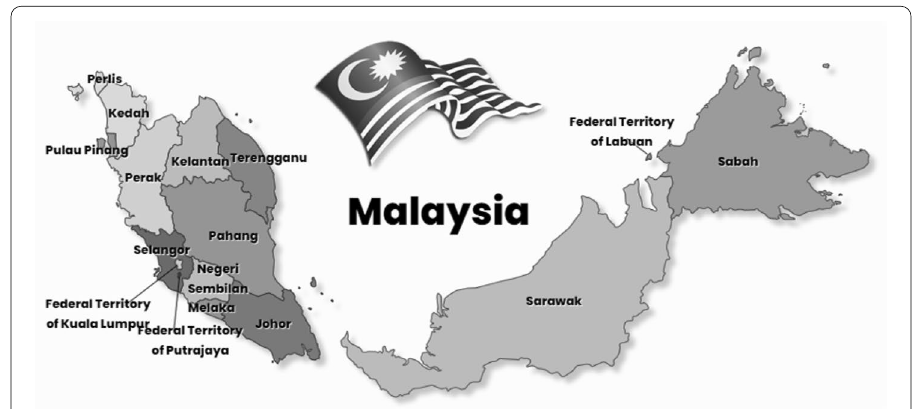
Fig. 1 Map of Malaysia. Source: https:// www. dosm. gov. my/ v1/ index. php?r ZmVrN 2FoYn BvZE0 5T1Az K0RLc EtiZz